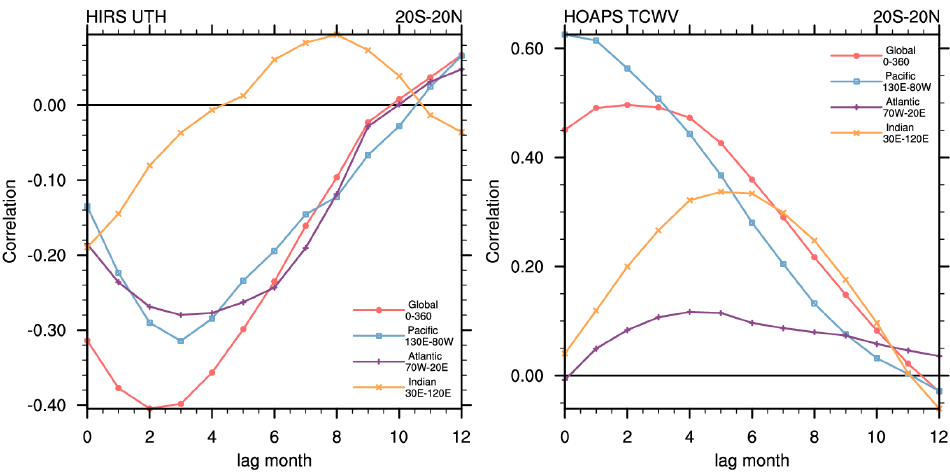
Figure 9. Lag correlations of the Niño 3.4 index leading UTH ( left panel ) and TCWV ( right panel ) for